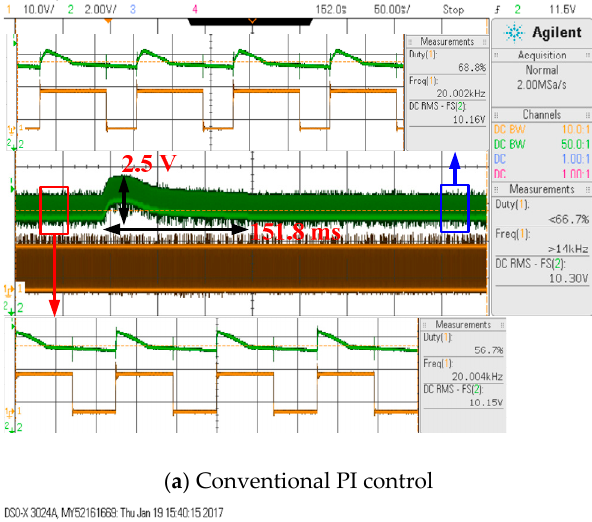
( b ) SM control Figure 9. The waveforms of V out and the switching signals when the phase displacement is altered from 100° to 110°.